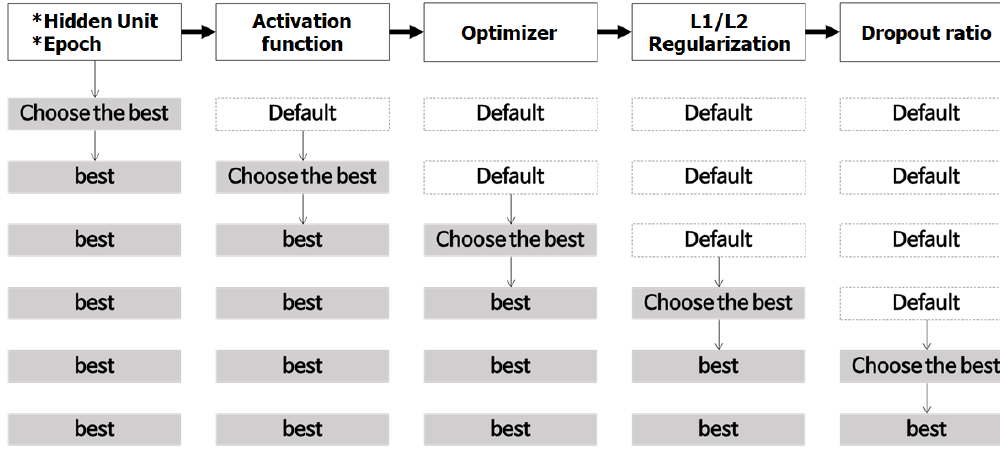
Figure 4. Hyperparameter optimization for the deep neural network (DNN) model of this study.